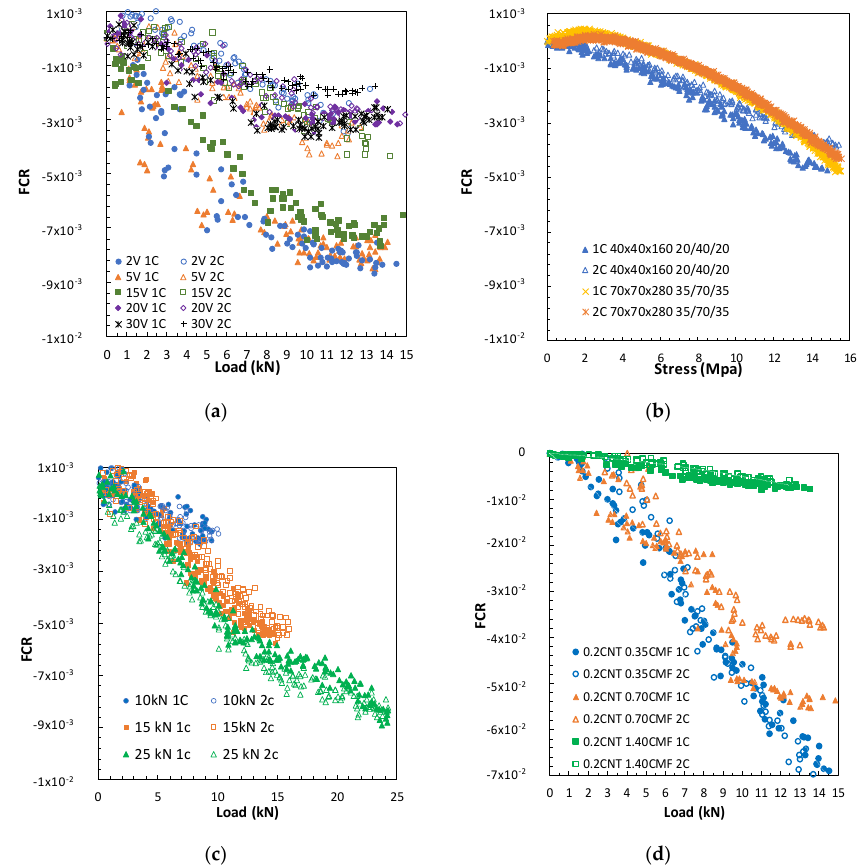
Figure 11. FCR and Load relationship for SCC with CNT + CMF. ( a ) voltage, ( b ) Sensor distance, ( c ) Load level and ( d ) CMF